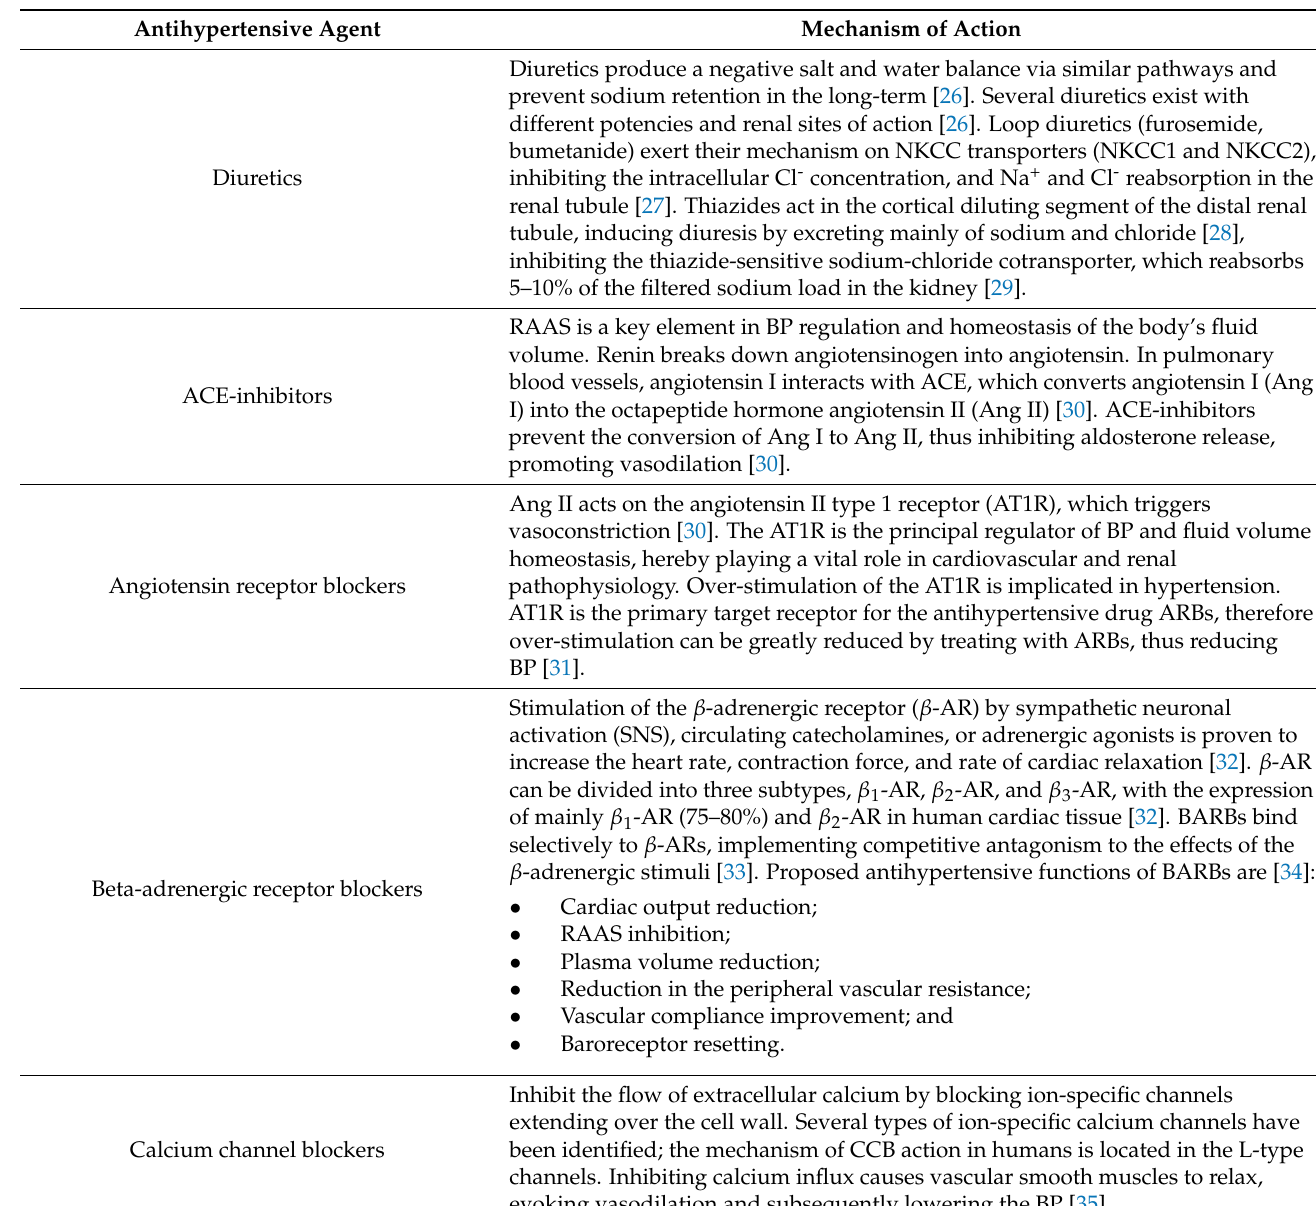
Table 2. Mechanisms of action of the different antihypertensive drug classes. Antihypertensive